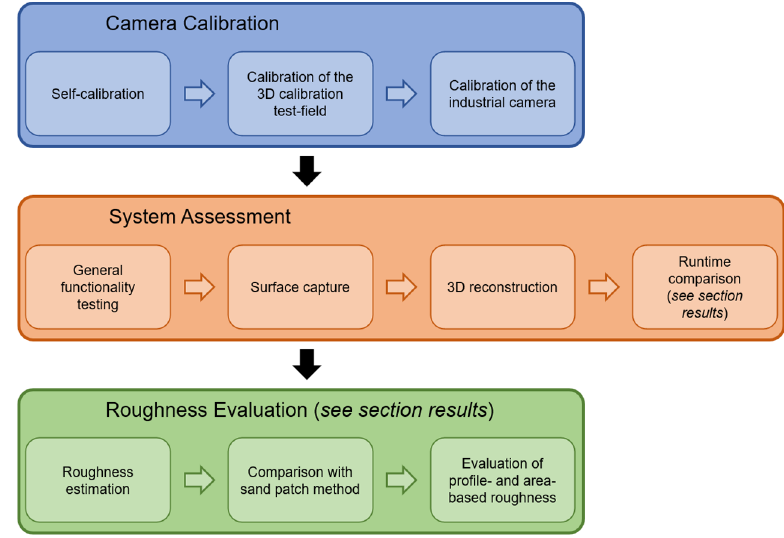
Figure 11. Overview of the conducted experiments.